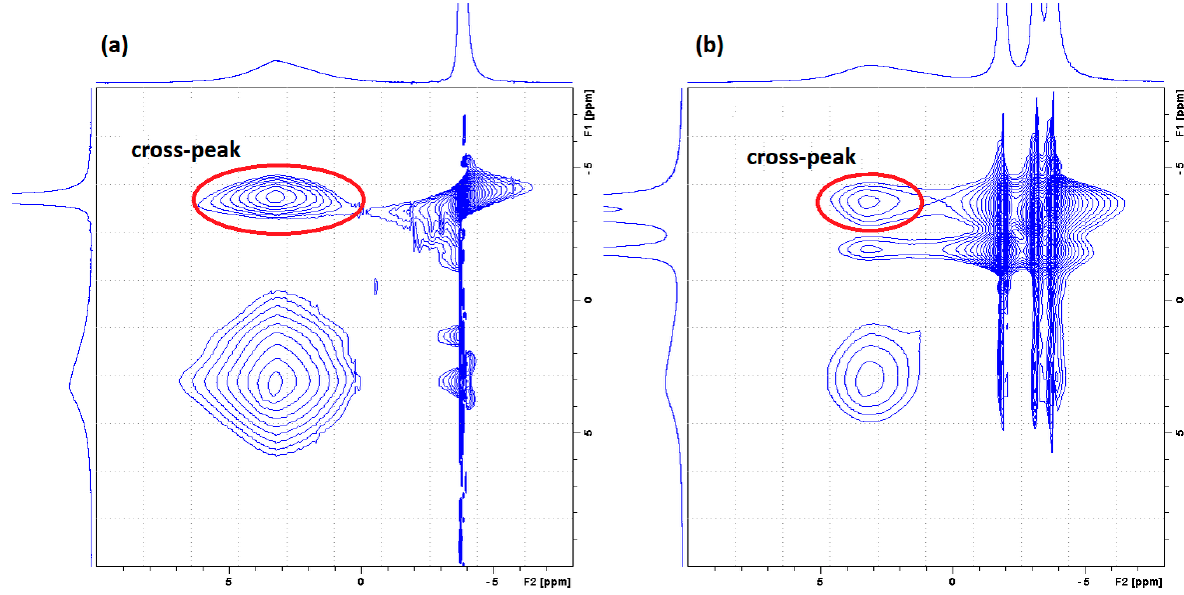
Figure 4. 1 H MAS solid-state EXSY NMR spectra of BCPs I ( a ) and II ( b ) with t mix = 25 ms for films casted from butyl acetate.